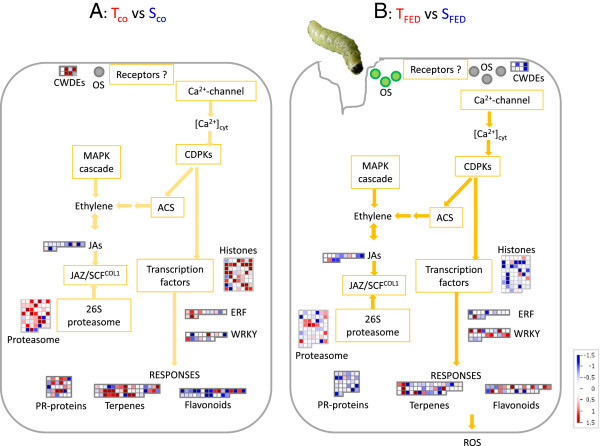
Model of a signalling cascade for oak’s constitutive and induced defence response. The model of the cascade is derived from a model recently published by Arimura et al.[32]. A: In the unfed control, the cascade is expected to be triggered by some 'damaged-self’ oligosaccharids (OS; grey circles) acting as elicitors activated by constitutively expressed cell wall degrading enzymes (CWDE; higher expressed in T-oaks than in S-oaks). B: Feeding by the leaf chewing insect T. viridana induces the release of herbivore-derived OS (green circles; elicitors) as well as of 'damaged-self’ OS and therefore initiates the cascade. The cascade itself is the same for the constitutive and induced defence response with different expression of transcripts in T- and S-oaks. Red squares represent transcripts stronger expressed in T-oaks and blue squares represent transcripts with higher expression in S-oaks. Transcripts assigned to the following MapMan BINs are presented: cellulases and beta -1,4-glucanases (CWDEs) belonging to cell wall degradation, jasmonate (JAs) related to hormone metabolism, proteasome (Proteasome) belonging to protein degradation, isoprenoids (Terpenes) and flavonoids (Flavonoids) related to secondary metabolism, ERF transcription factor family (ERF, ethylene-responsive factors), WRKY transcription factors (WRKY) belonging to regulation of transcription, histone (Histone) related to DNA synthesis/chromatin structure. Abbreviations: ACS, 1-aminocyclopropane-1-carboxylate; JAZ, jasmonate ZIM-domain; OS, oligosaccharids (elicitors); ROS, reactive oxygen species; SCF, SCF-type E3 ubiquitin ligase SCFCOI1.